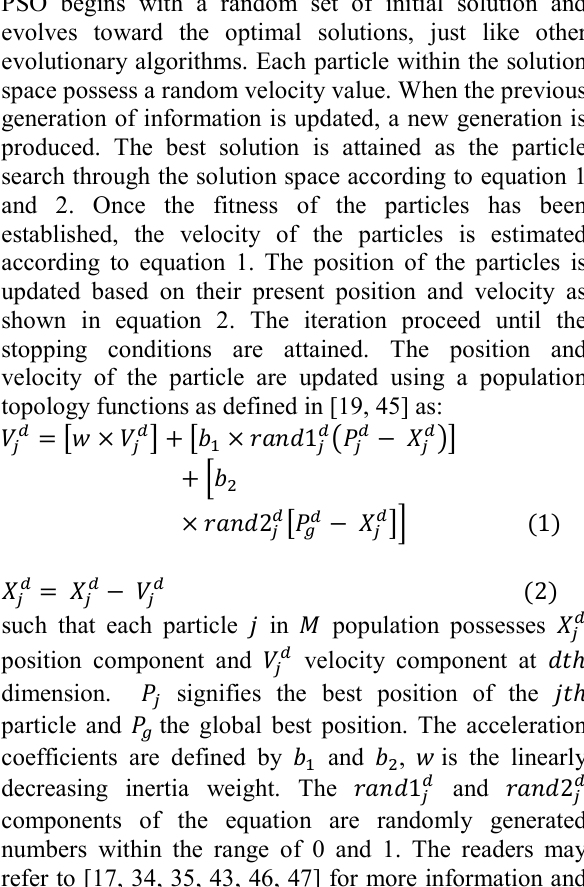
Figure 1. Flow diagram of PSO-ANFIS Algorithm